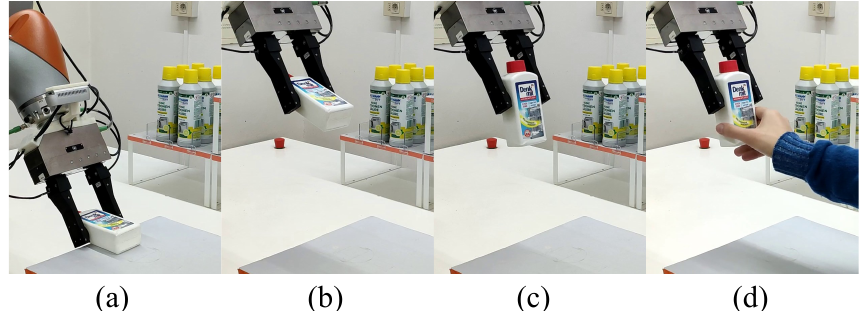
Figure 14. Snapshots of the third experiment: ( a ) grasp configuration; ( b ) after lifting; ( c ) after pivoting; ( d ) handover.